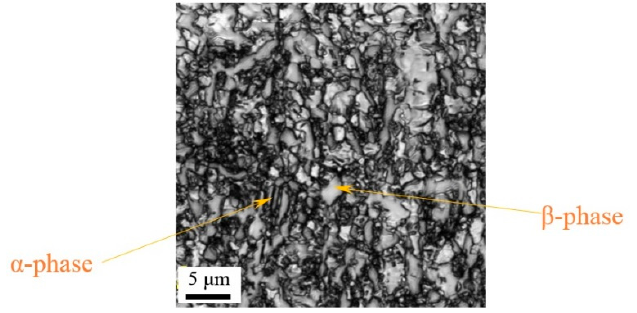
Figure 2. Microstructure of the VT23 alloy.